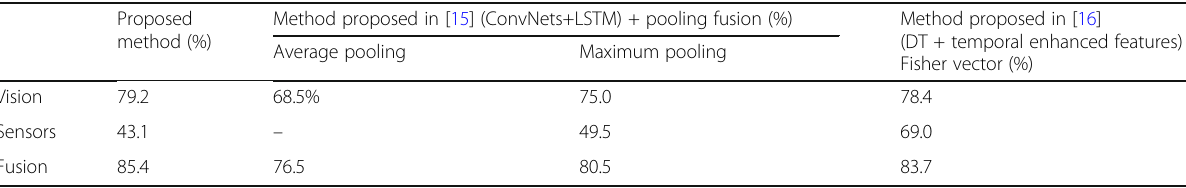
Table 9 Comparison of different methods on their respective datasets Proposed method